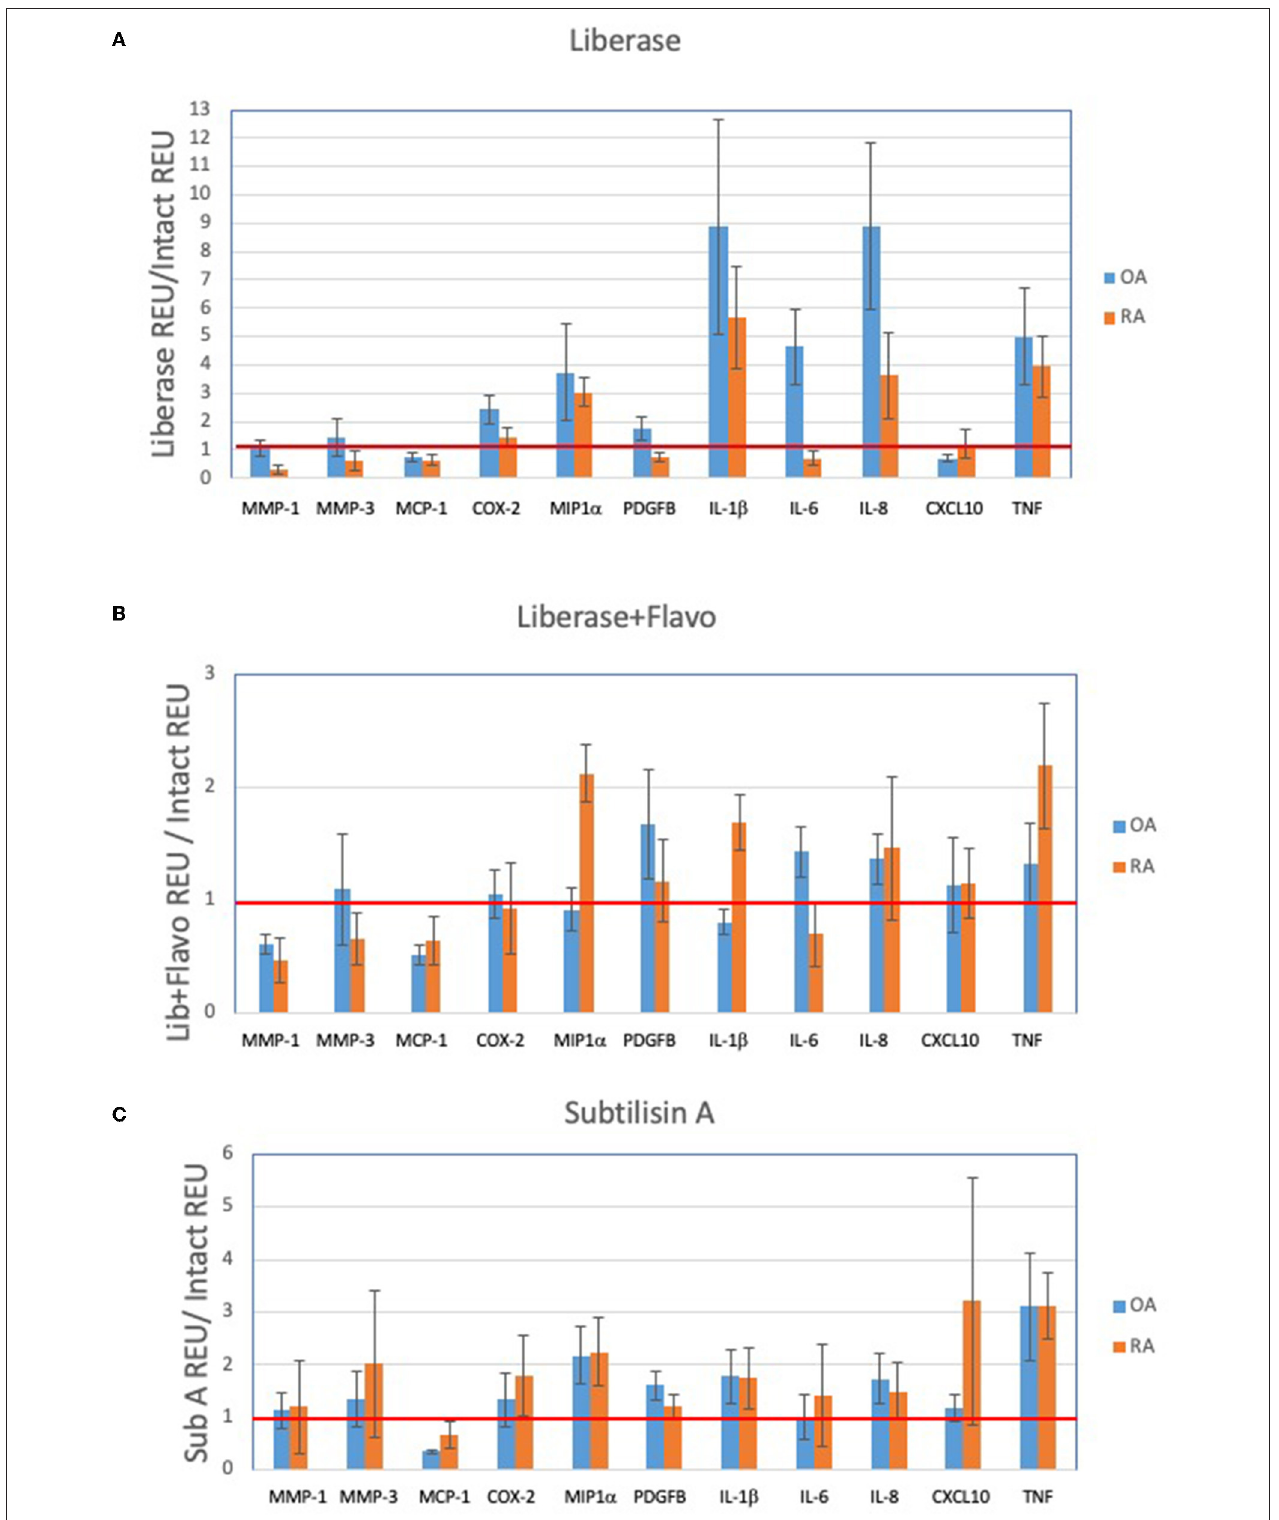
FIGURE 2 | Effect of disaggregation on select 11 transcripts. Expression of candidate genes in disaggregated tissue is normalized to expression in parent (intact) tissue. (A) Lib, (B) Lib + Flavo, and (C) SubA. Line at 1.0 indicates identical disaggregated and intact expression, above 1.0 indicates induction or enrichment and below 1.0 indicates lower gene expression after disaggregation. Normalization illustrates the differential effects of disaggregation on individual transcripts. Note scale differential effects of disaggregation.